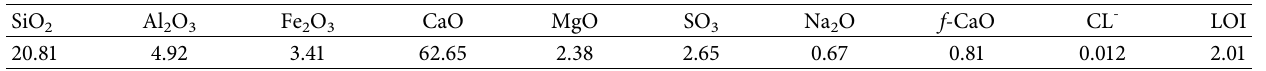
Table 2: Chemical components of cement (wt.%).